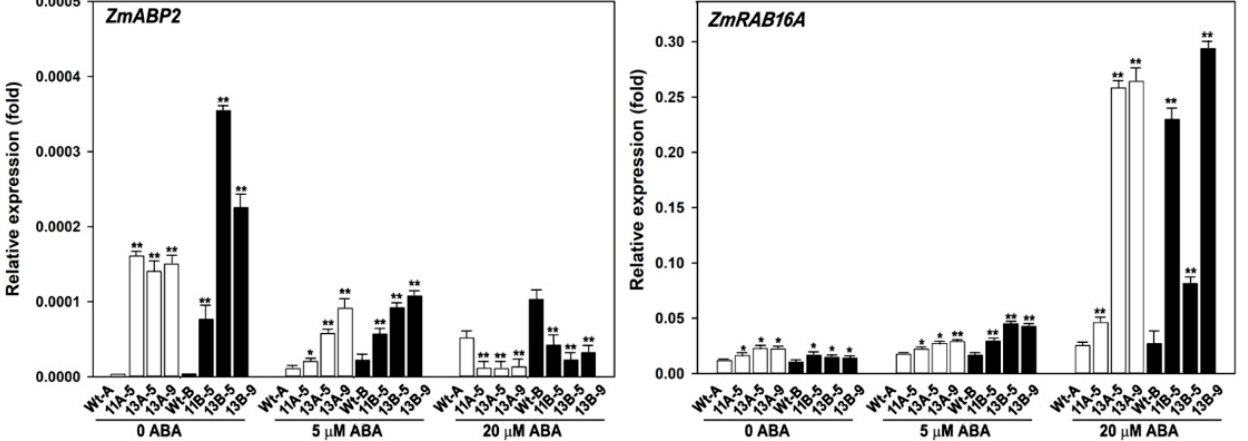
Figure 5. Expression patterns of ABA-inducible genes in OsPYL / RCAR7-OX transgenic maize lines. Each transcript was detected in seedlings treated with the indicated concentration of ABA for 12 h. Bars represent the means ± SE of three replicates. Asterisks represent significant differences from the untransformed wild type (*, 0.01 < p -value < 0.05; **, p -value < 0.01). Wt, untransformed wild type; 11A-5 to 13B-12, selected transgenic lines.